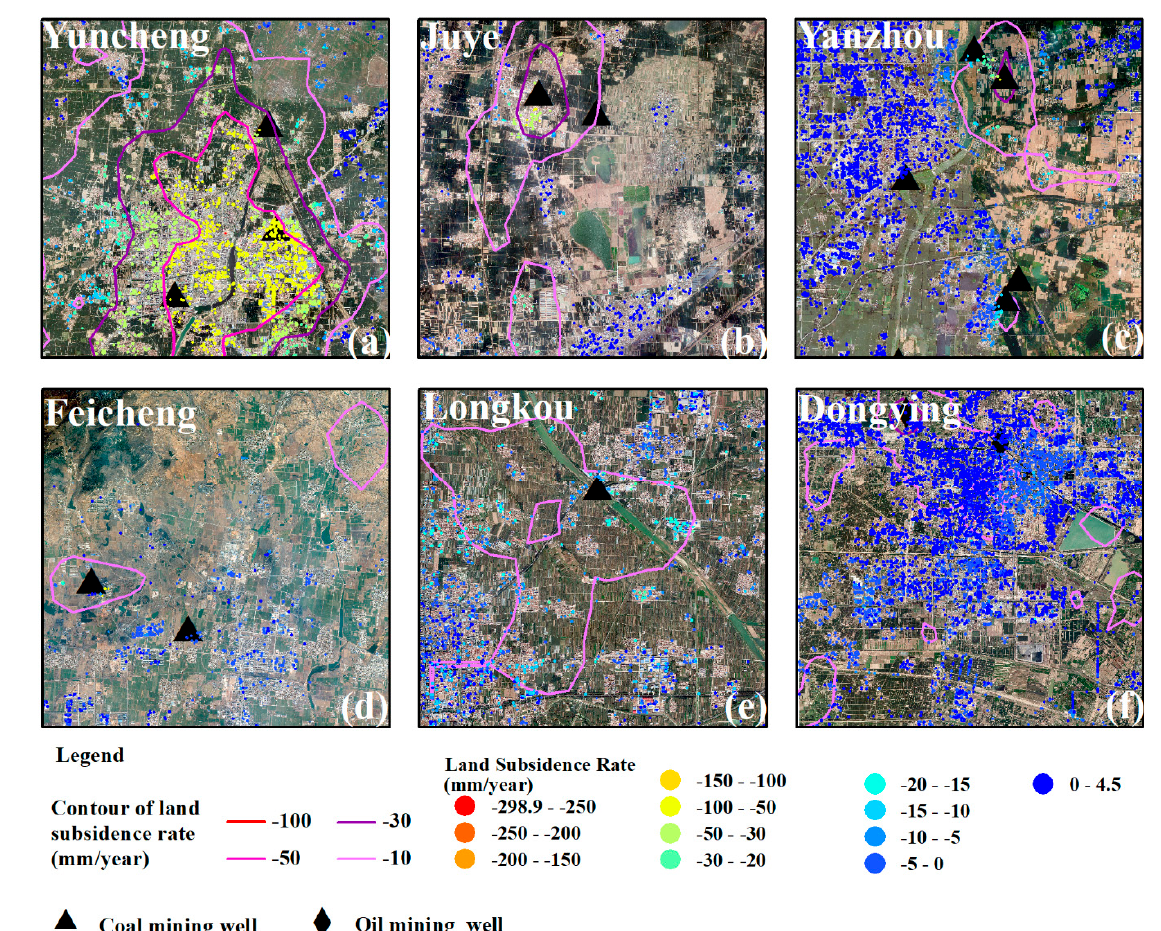
Figure 12. Six typical mining areas in the SDP.